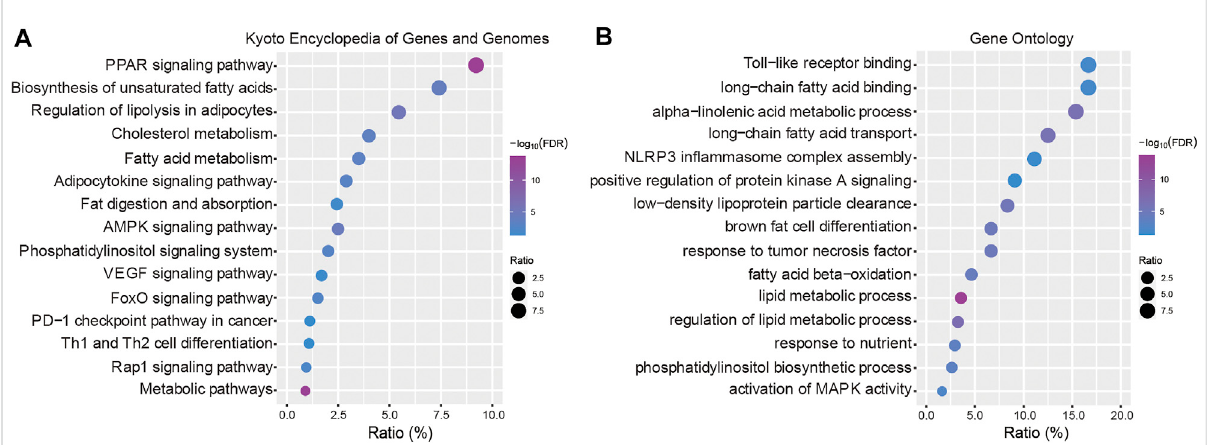
FIGURE 4 Functional enrichmentanalysis. (A) KyotoEncyclopediaofGenesandGenomes(KEGG)pathwaysenrichedinthekeyLMGs. (B) GeneOntology (GO) terms. “ Ratio ” presents the number of genes in our data/the number of all genes in terms or pathways. LMGs: Lipid metabolism-associated genes. The false discovery rate (FDR) < 0.05 was considered as threshold. The lower boundary value for the -log10(FDR) is 1.301 and the upper boundary value is in fi